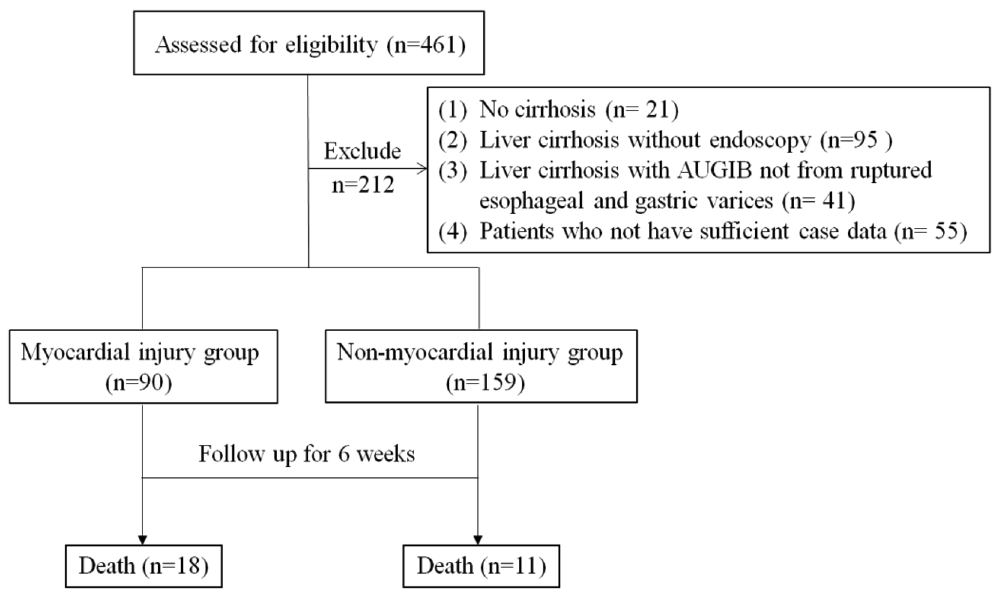
Figure 1. Flow chart for patient